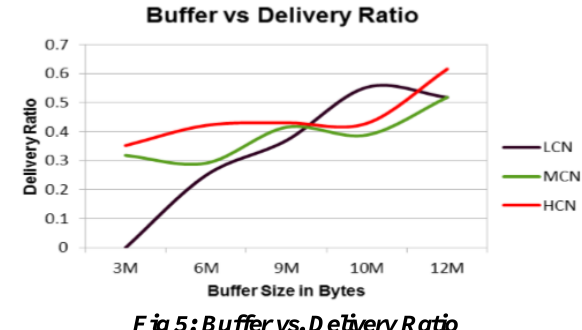
Fig 5: Buffer vs. Delivery Ratio